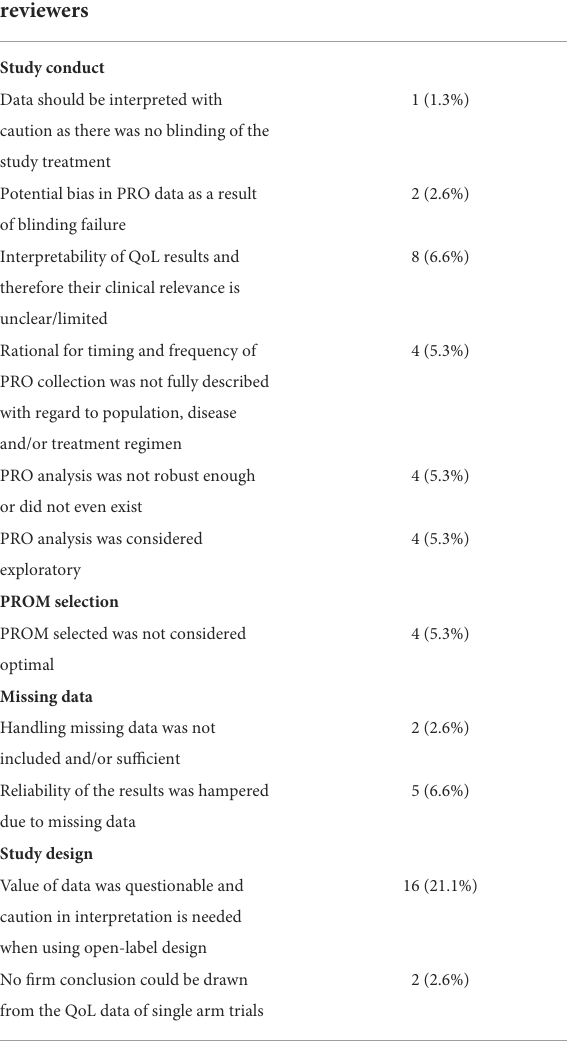
TABLE 4 Reasons for patient-reported outcomes label claims exclusion identified in European public assessment reports reviewers ’ comments ( n =